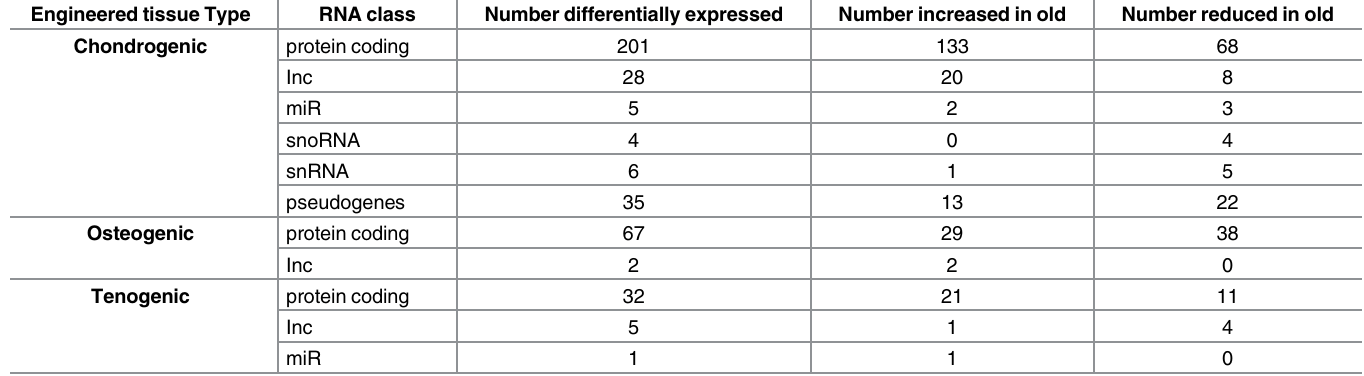
Table 1. Differentially expressed RNAs in chondrogenic, osteogenic and tenogenic engineered tissues based on RNA class ( ± 1.4 log2 fold change, FDR < 0.05). Engineered tissue